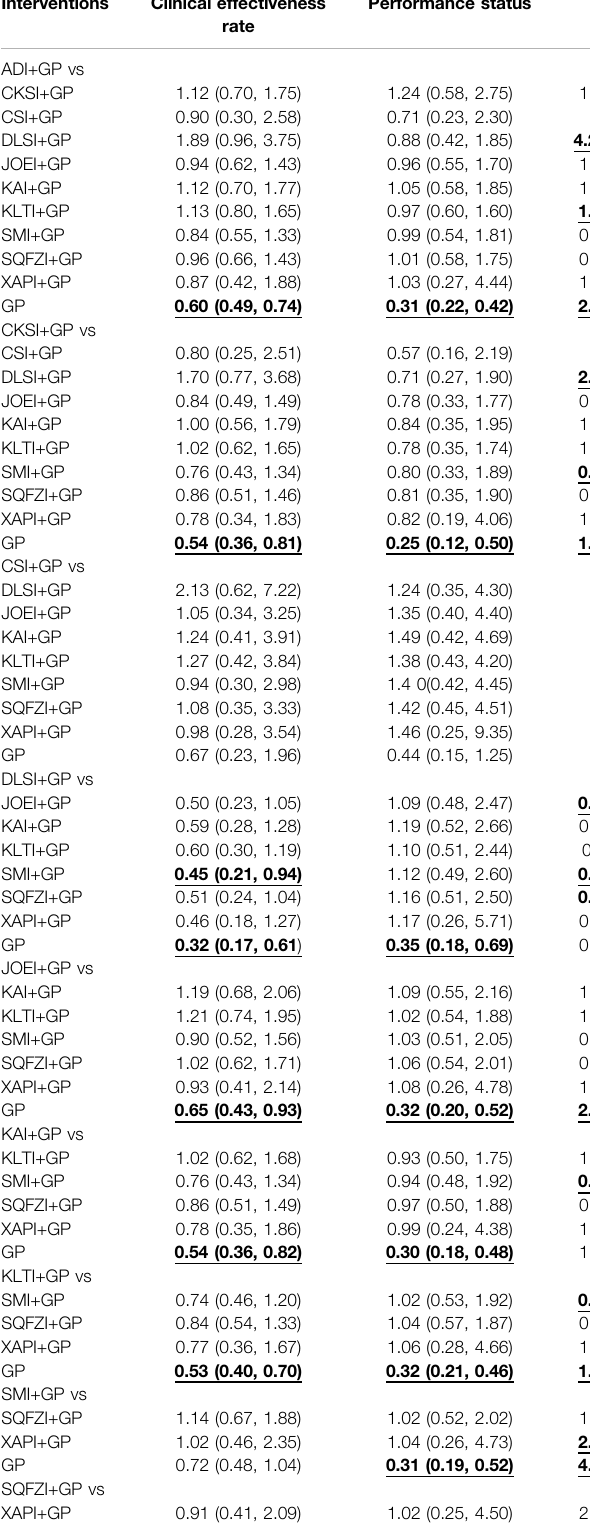
TABLE 2 | Odds ratio/mean difference (95%CI) of all therapeutic interventions.